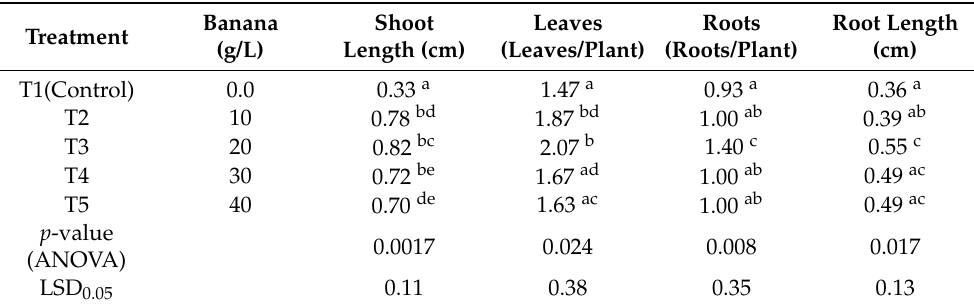
Table 6. Effect of mashed banana on the growth and development of D. anosmum Lindl. (6 weeks after culturing).